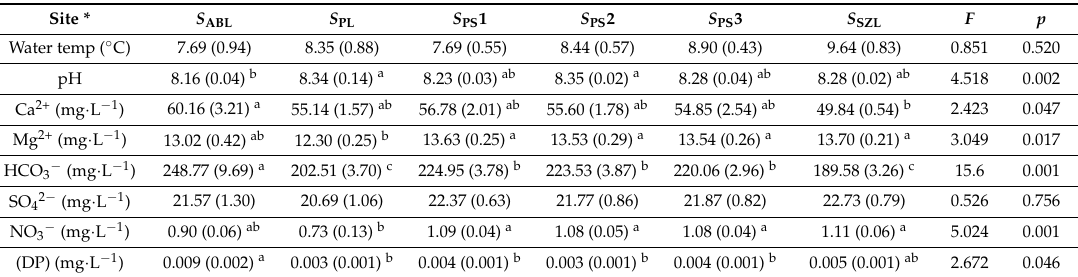
Table 2. Hydrochemistry measurements at the studied